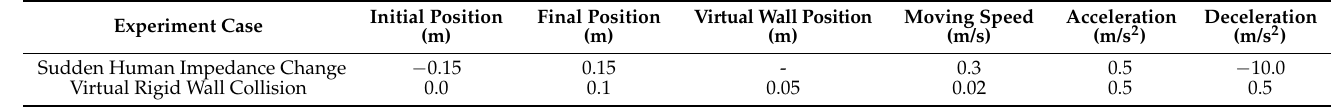
Table 3. Environment parameters for experiments.